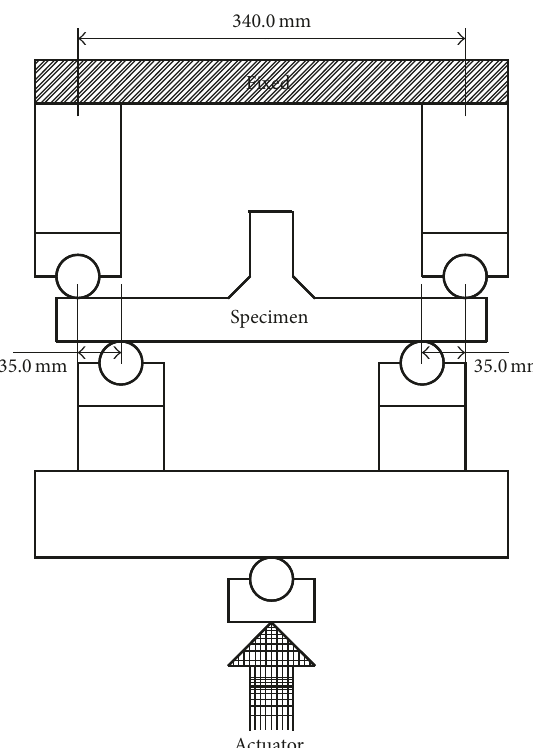
Figure 6: Loading set-up for fatigue testing.